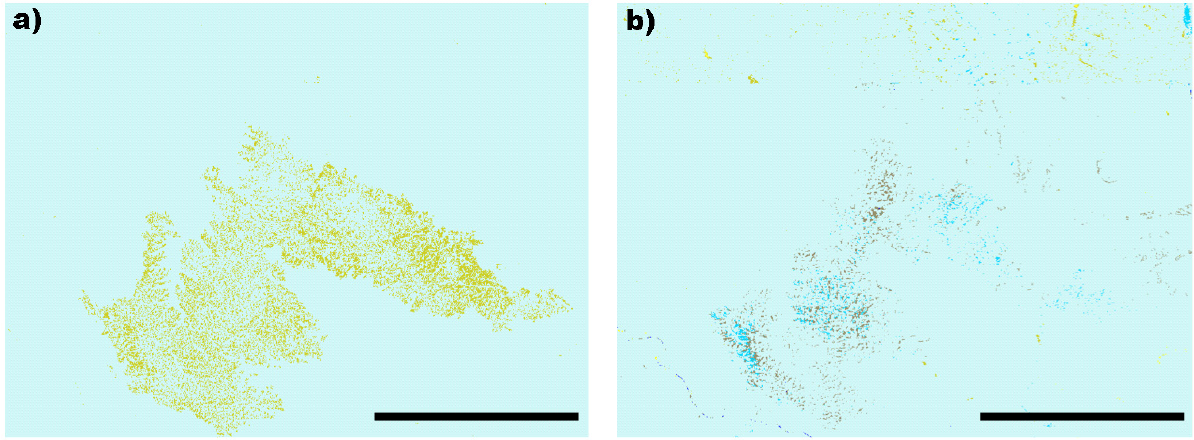
Figure 11. ( a ) Melack and Hess classification, where off-yellow indicate maximum extent of flooded shrubs; ( b ) ALOS classification, where dark blue and medium blue indicate maximum extent of open water and brown represents areas of steep slope not likely to be inundated. The flooded shrub classes tend to be classified as not inundated in the ALOS classification. (center coordinates: − 8.487°, − 61.788° shown by letter “z” in Figure 3, black bar indicates 50 km